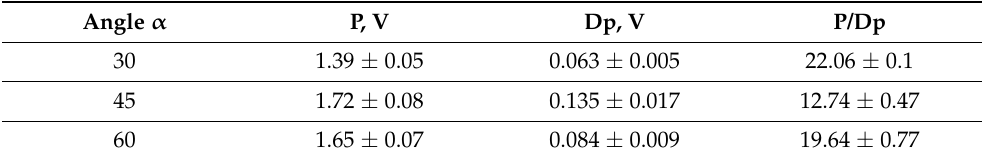
Table 1. The values of average surface potential (P), dispersion of surface potential values (Dp), and their ratio (P/Dp) in relation to the exposure angle α